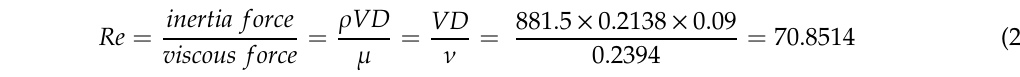
Figure 9. Characteristic graph of the fluid.